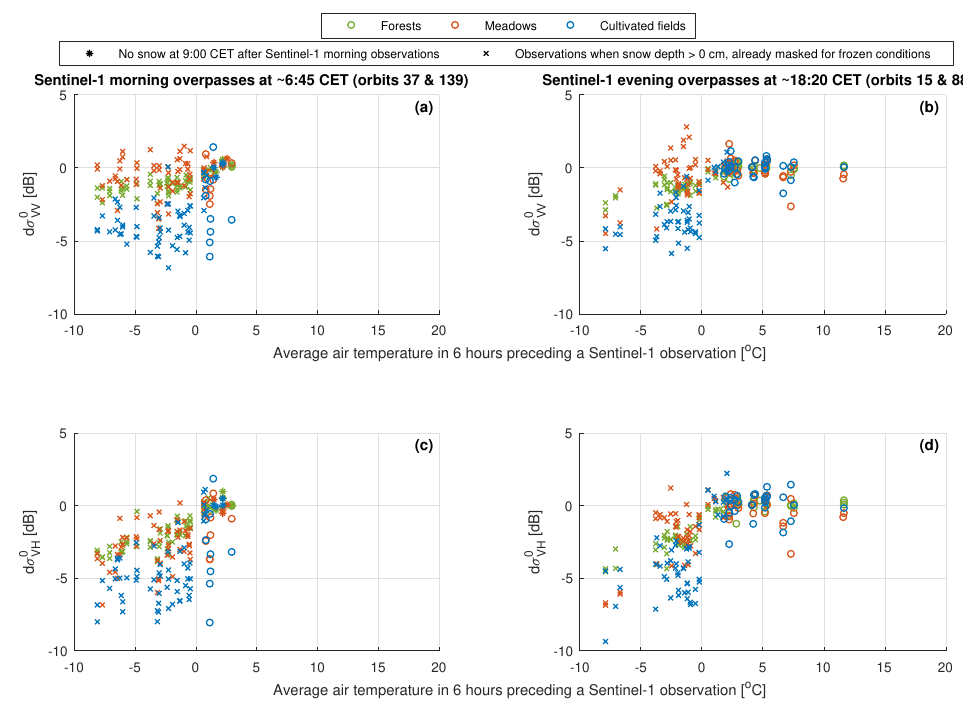
Figure 6. The effect of snow depth on the seasonal anomalies ( d σ 0 ) of the Sentinel-1 σ 0 observations in VV polarization ( a ) and VH polarization ( b ). Each data point represents a single Sentinel-1 observation. The Sentinel-1 observations masked for frozen conditions are not included, whereas the Sentinel-1 observations that are masked for rain interception are included (marked with a cross).